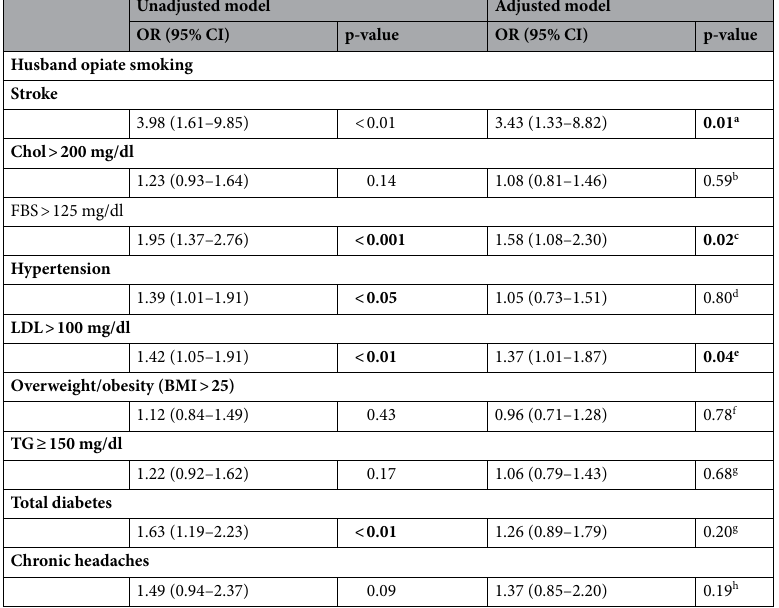
Table 2. Estimated unadjusted and adjusted odds ratios for stroke, stroke risk factors and predictive parameters in women, as predicted by husband opiate smoking. Estimated unadjusted and adjusted odds ratios for stroke, high Chol, FBS, hypertension, LDL, overweight/obesity, high Tg, diabetes and chronic headache in women, as predicted by husband opiate smoking. Significant values are in bold. OR odds ratio, CI confidence interval, LDL low density lipoprotein, Chol cholesterol, TG triglyceride. a Adjusted for age, education years, BMI, stage 2 hypertension, diabetes, MET and family history of stroke. b Adjusted for age, education years, BMI, stage 2 hypertension and family history of hypertension. c Adjusted for age, education years, BMI, MET and family history of diabetes. d Adjusted for age, education years, BMI, MET and family history of hypertension. e Adjusted for age, education years, BMI, stage 2 hypertension, diabetes and family history of hypertension. f Adjusted for age, education years, MET and diabetes. g Adjusted for age, education years, BMI, MET and family history of diabetes. h Adjusted for age, education years, stage 2 hypertension and family history of recurrent chronic